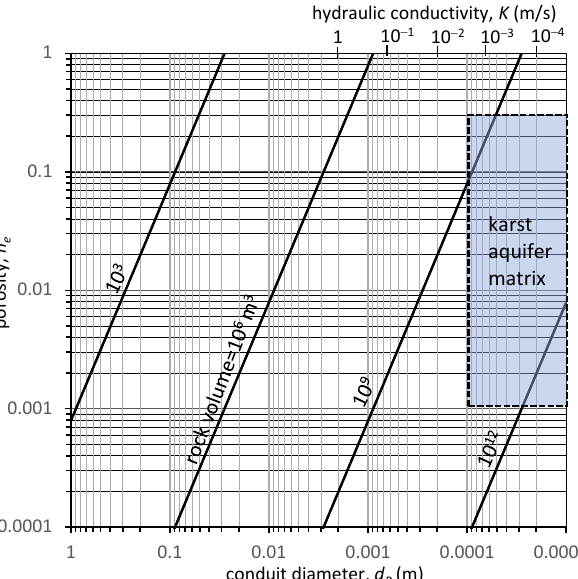
Figure 5. Relationship between conduit diameter, d P , and the porosity, n e , for different rock volumes (data from Table 1). Hydraulic conductivity, K , has been estimated up to a value of 1 m/s; the zone of karst aquifer matrix is also highlighted.